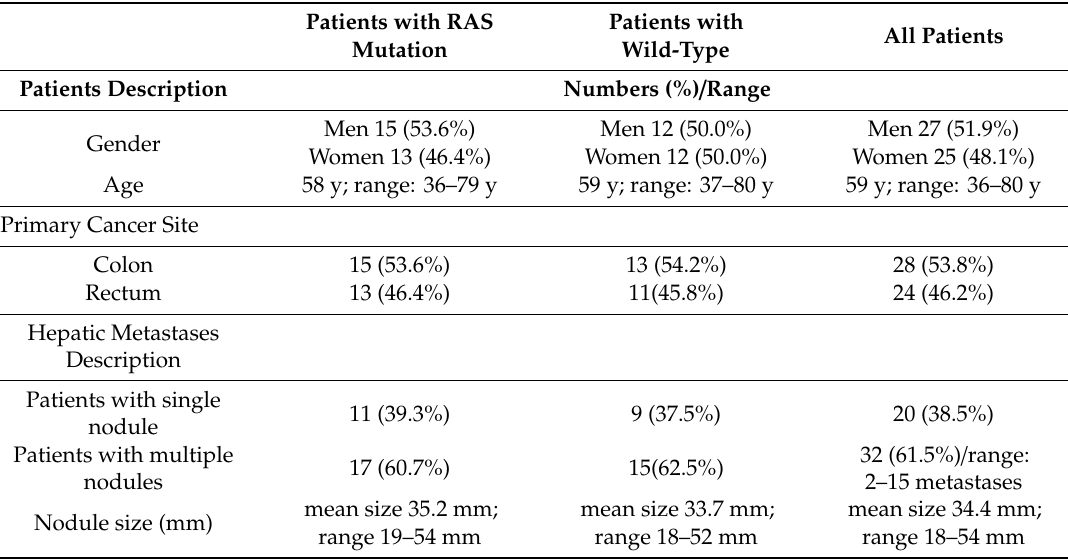
Table 1. Characteristics of the study